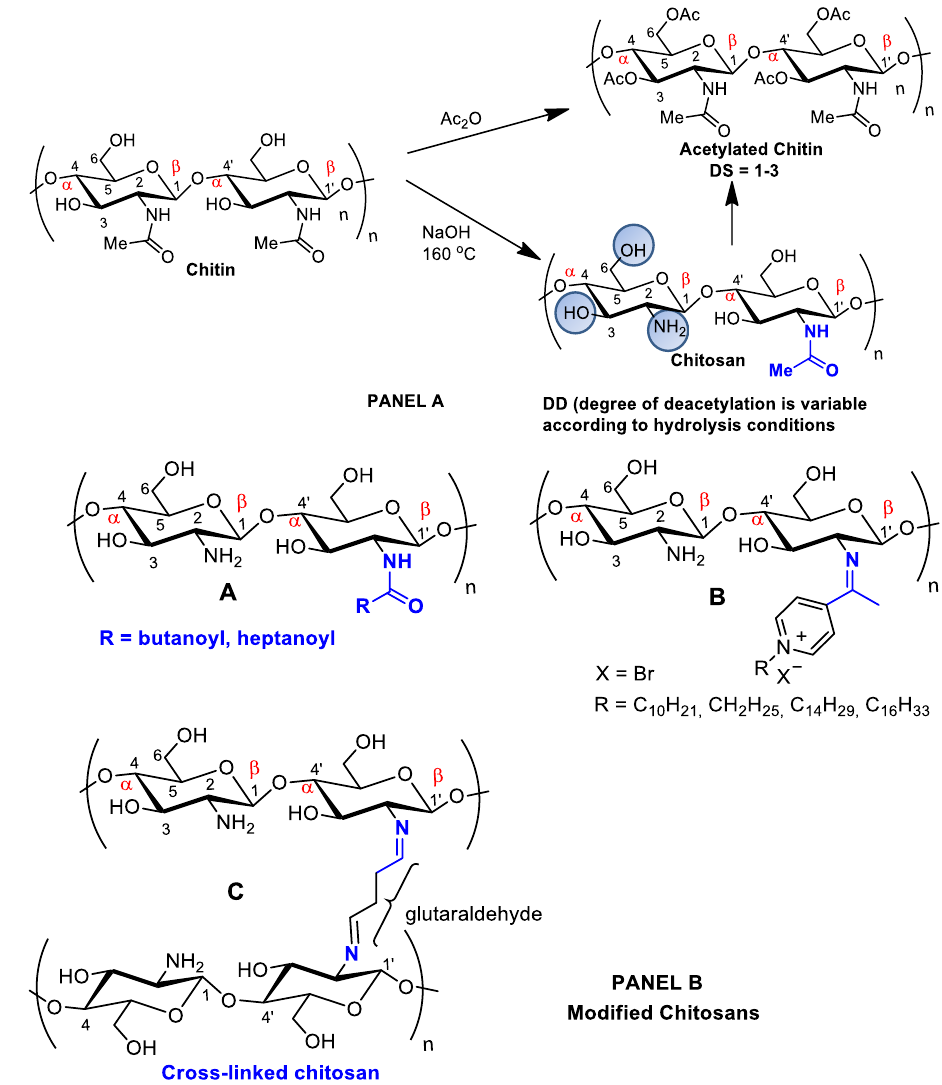
Figure 2. Panel ( A ): chitin and chitosan acetylation and deacetylation without alteration of the degree of polymerization. Chitin acetylation varies from 1 – 3 (DS = 1 – 3). Panel ( B ): chitosan structural modifications through amino group reactions with butanoyl or hepatanoyl (A), pyridine (B) or chitosan fibers crosslinking with glutaraldehyde (C).